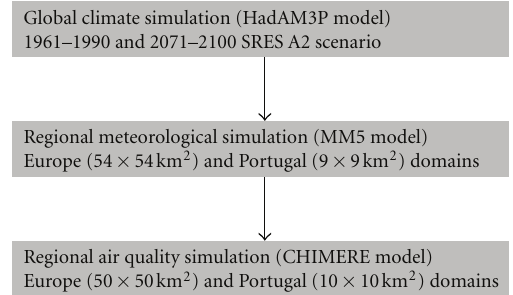
Figure 2: Schematic representation of the air quality numerical si-